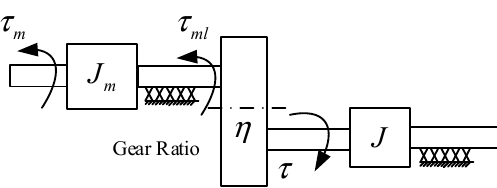
Figure 2. Transmission structure from robot motor end to joint end.